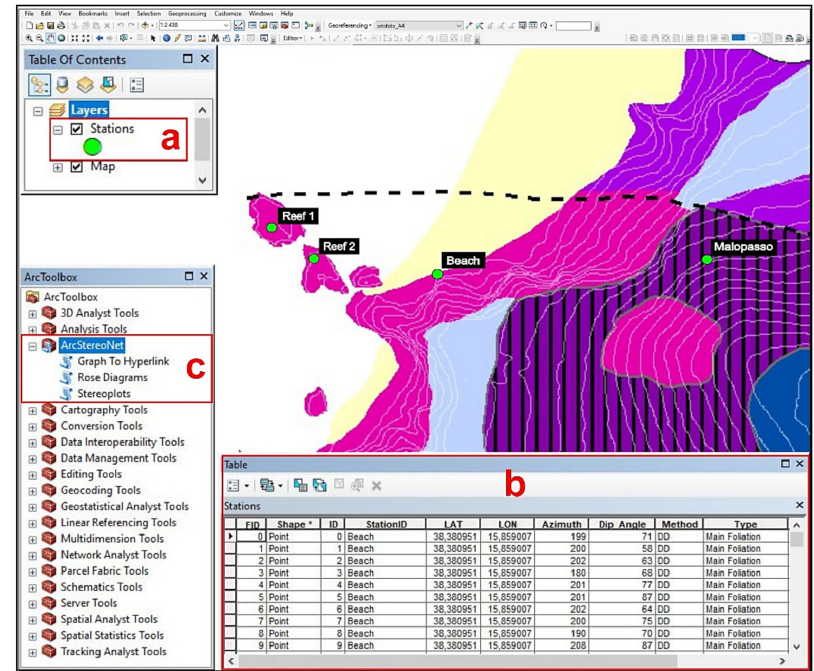
Figure 1. Example of ArcMap ® (version 10.6.1) equipped with ArcStereoNet. After creating a shapefile storing oriented data ( a ) and selecting the records stored inside its attribute table ( b ), the user can